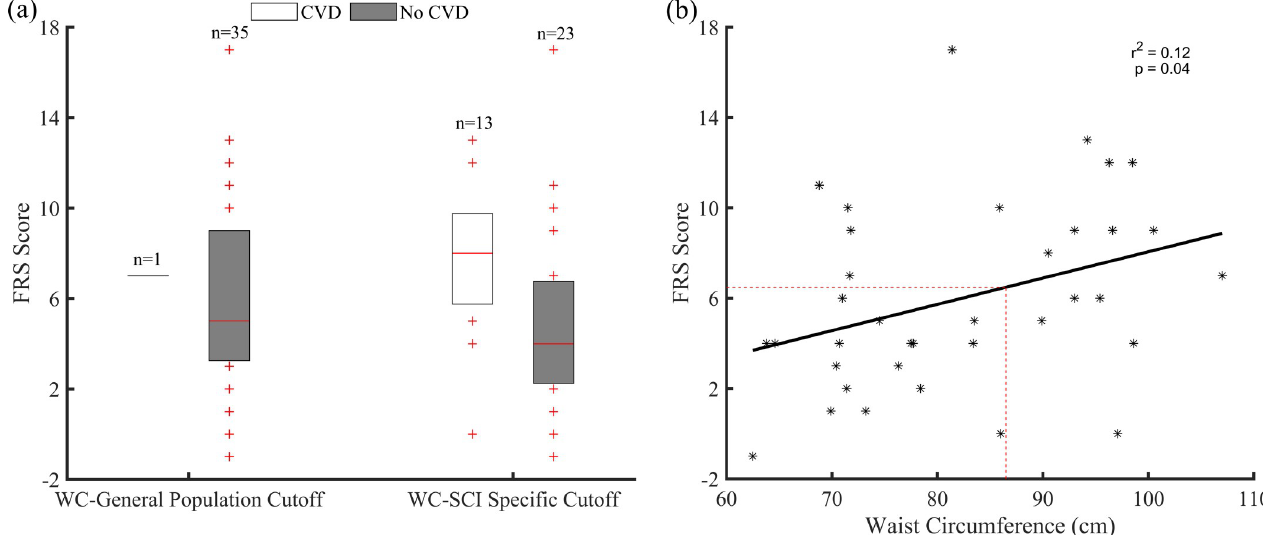
Fig 4. (a): Distribution of FRS score for those classified at risk “CVD” and “No CVD” using either general population (102 cm) or SCI specific (86.5 cm) cutoff points of WC. (b): Association between FRS score and waist circumference.